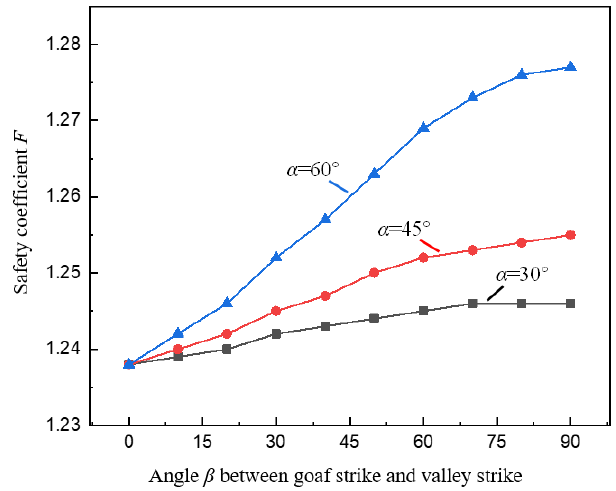
Figure 12. Relationship between goaf strike and stress concentration coefficient F .